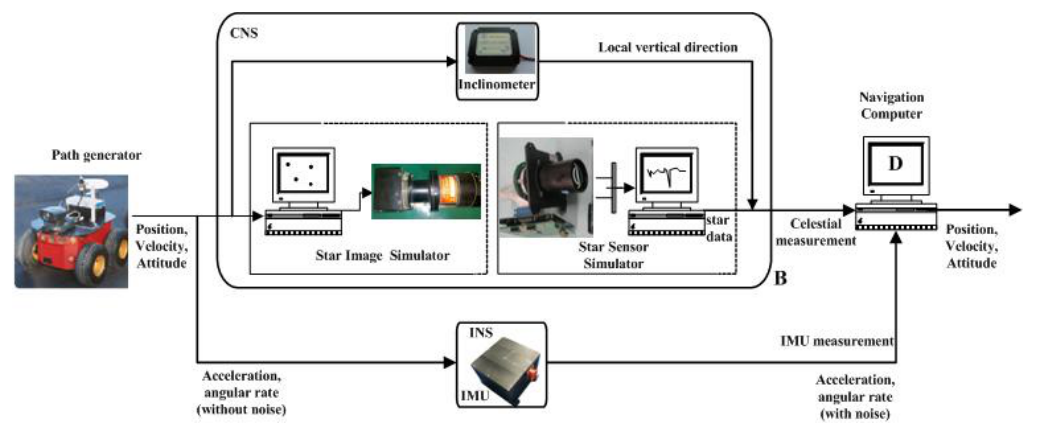
Figure 4. Lunar explorer INS/CNS simulation